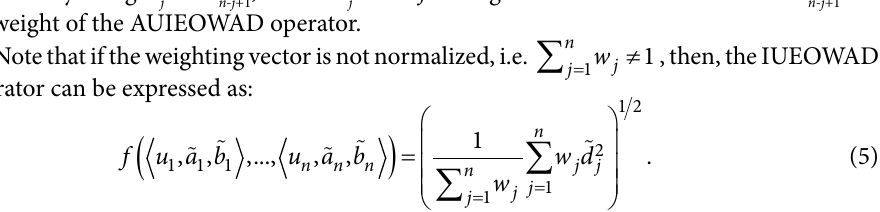
numbers operations. Second, final evaluation values of uncertain induced aggregation